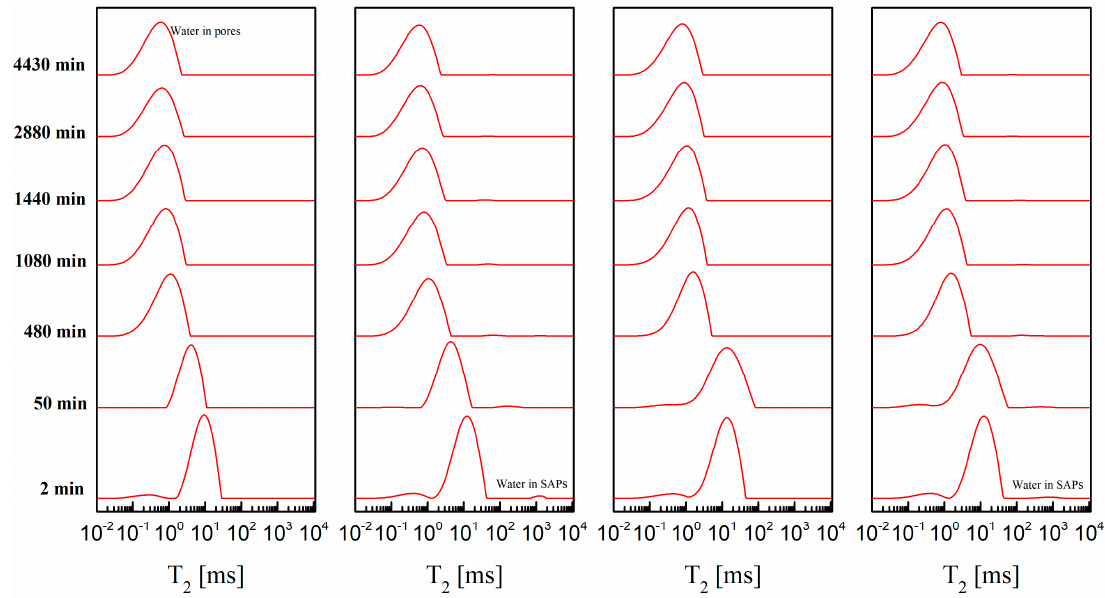
Figure 5. Selected relaxation time distributions of the cement paste containing accelerators with or without superabsorbent polymers (SAPs).